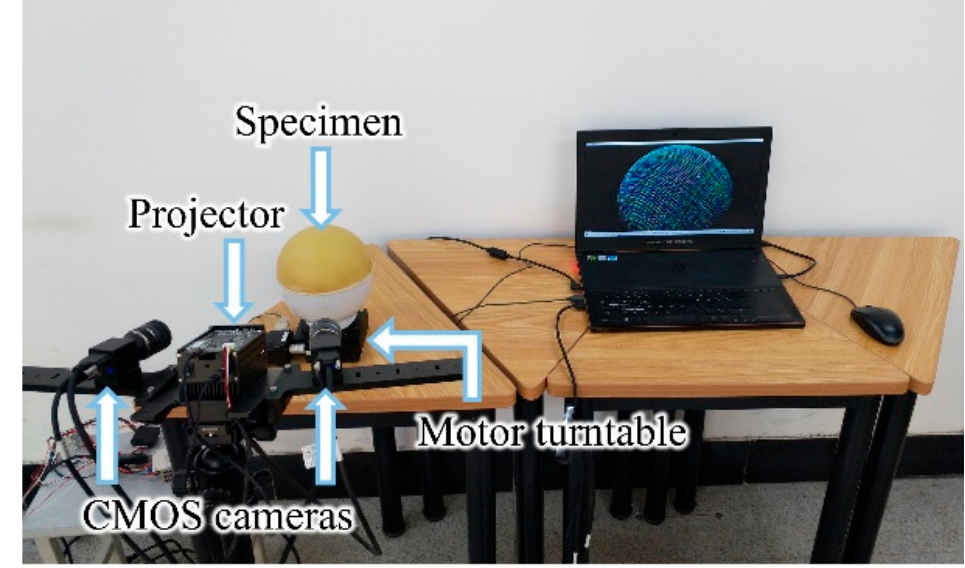
Figure 2. The binocular structured light 3D measurement system.